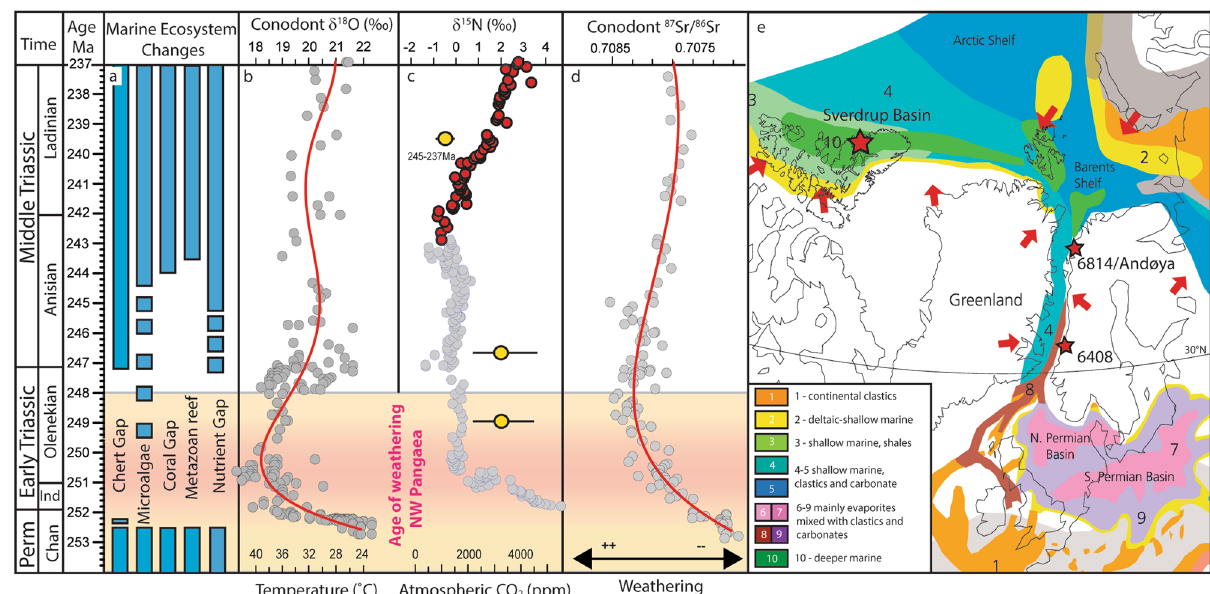
Fig. 10 Paleoclimatic and -ecological evolution during the Late Permian to Middle Triassic. a Marine ecosystem changes during the ETBC 4,5 . b Tropical sea surface temperatures (SST) inferred from stable oxygen isotopes on conodonts 8 . c Composite nitrogen isotope ( δ 15 N) record from Sverdrup Basin with previously published data in light blue circles 5,35 and new data (Otto Creek) for this study highlighted in red. CO 2 data (yellow circles) from Royer 99 . d Weathering variability inferred from strontium isotopes on conodonts 8 . e Paleogeographic reconstruction of NW Pangea during the early Triassic 100 . The site locations of this study are marked by red stars. Arrows indicate potential pathways of detrital sediment discharge. Timing of intense continental weathering ( ∼ 254 – 248 Ma) as revealed from K-Ar geochronology of authigenic K-bearing minerals in cluster 3 (Fig. 7) are indicated by beige horizontal